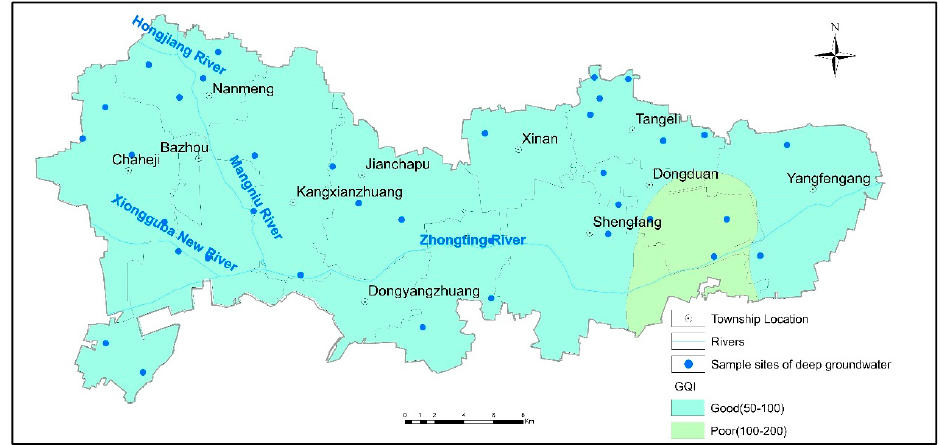
Figure 7. Spatially distributed groundwater quality index (GQI) values in the study area. The fluoride concentration of deep groundwater in the study area ranged from 0.29 to 4.21 mg/L and the mean value was 2.23 mg/L. We found 79.0% of the groundwater samples with a fluoride concentration higher than the Class III water limit of SGQC (1 mg/L) and 65.8% of the samples with a fluoride concentration exceeding the permissible limit-concentration specified by the WHO (1.5 mg/L), indicating that there is a risk of ex- cessive fluoride in groundwater. Physical or chemical methods need to be used to reduce the fluorine concentration in the groundwater of the study area. Iodine test results showed that 21.1% of deep groundwater samples exceeded the Class III standard (0.08 mg/L) ac- cording to SGQC. Excessive iodine intake can cause diseases such as thyroid function dis- ease [63]. Monitoring work for iodine concentration in food should be further strength- ened, and it is significant to take iodine reduction measures such as stopping iodine salt and water source modification in high iodine areas. Based on a comprehensive water quality evaluation method recommended by SGQC, 9 of the 38 groundwater sampling points in the study area were classified as the Class III category, which were mainly distributed in the west of the study area. Twenty of the deep groundwater samples were classified as Class IV, and nine were classified as Class V, which were mainly distributed in the east of the study area. According to the SGQC groundwater quality classification standard and the current situation of deep groundwater quality, the study area could be divided into three parts: Class III zone, where groundwater is suitable for direct drinking water supply; Class IV groundwater area, where groundwater is suitable for drinking water supply after proper treatment; Class V zone, where groundwater is unsuitable for drinking water supply. The spatial distribution of drinking water quality suitability was interpolated using the Kriging inter- polation method and visualized using ArcGIS software (Figure 8). It can be seen that the deep groundwater quality in the western study area is suitable for direct drinking. The deep groundwater in the central parts of the study area including Kangxinzhuang Town, Jianchapu Town, Dongyangzhuang Town and Tangerli Town could be used as a drinking water supply source after proper treatment. The deep groundwater in the central and eastern parts of the study area including Dongduan Town, Yangfengang Town, Wangzhuangzi Town and Shengfang Town may be inappropriate for a drinking water supply. Fluorine is the main factor excessing the standard values in groundwater of these